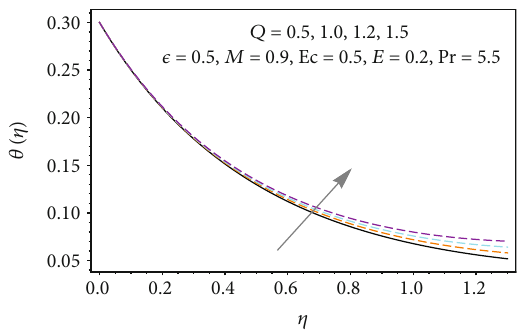
Figure 1: Illustration of the in fl uence of E on f ′ ð η Þ .